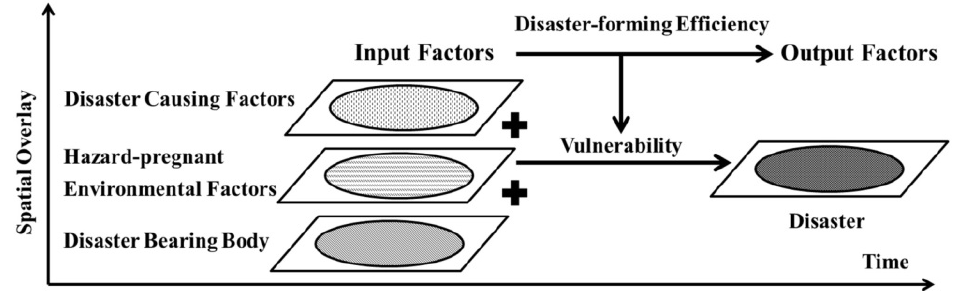
Figure 1. The process of regional natural disaster vulnerability assessment based on DEA model.